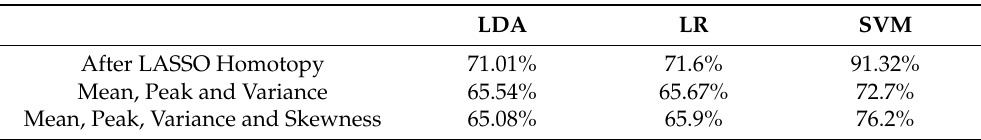
Table 5. Average classification accuracies of all subjects (%) were obtained by extracting features and selecting channels of HbO signals and classification using SVM, LDA, and LR of the walking and resting states (binary classification) of 9 subjects.